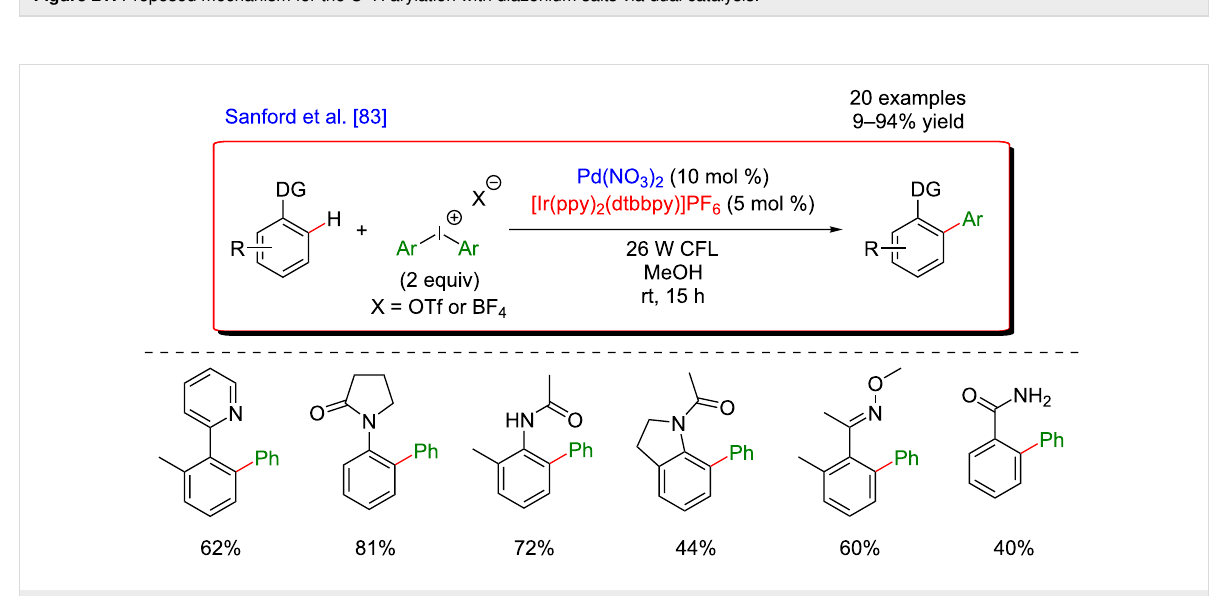
Figure 22: Dual catalysis merging C–H activation/photoredox using diaryliodonium salts.